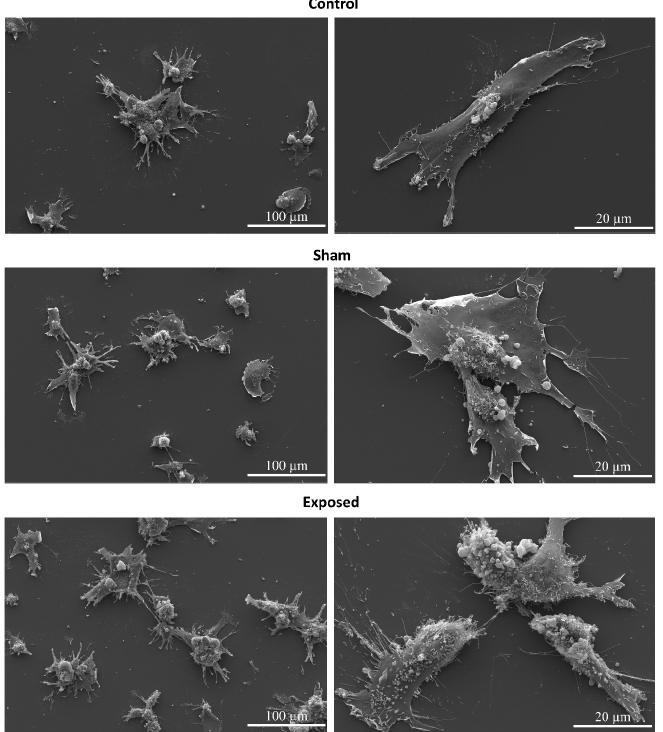
Figure 3. The morphology of hMSC. Experiment no. 1: day A—2 h after exposure to EMP. Scale bars represent the image magni fi cation.